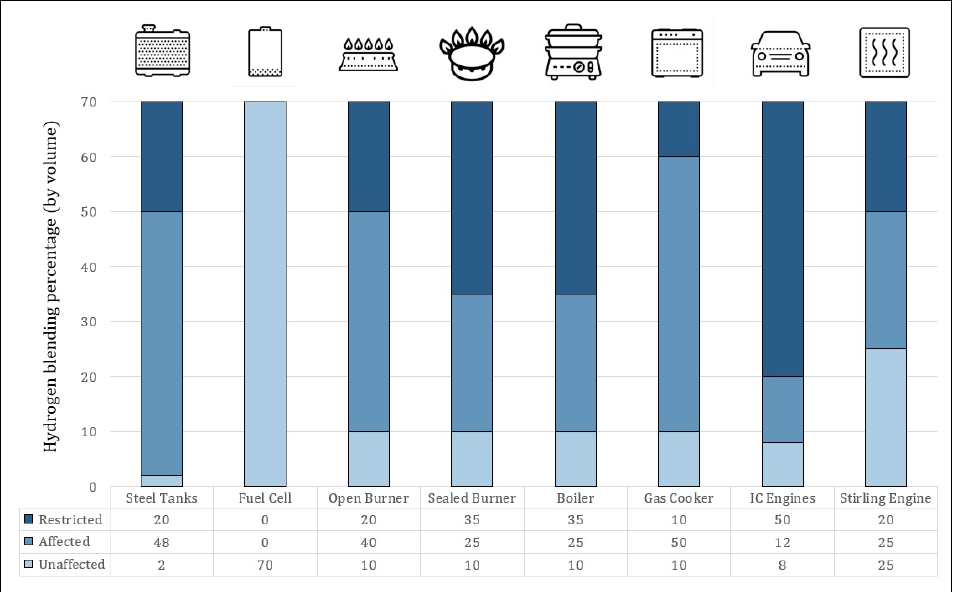
Figure 10. Susceptibility of P2G end-use applications to different volumes of hydrogen